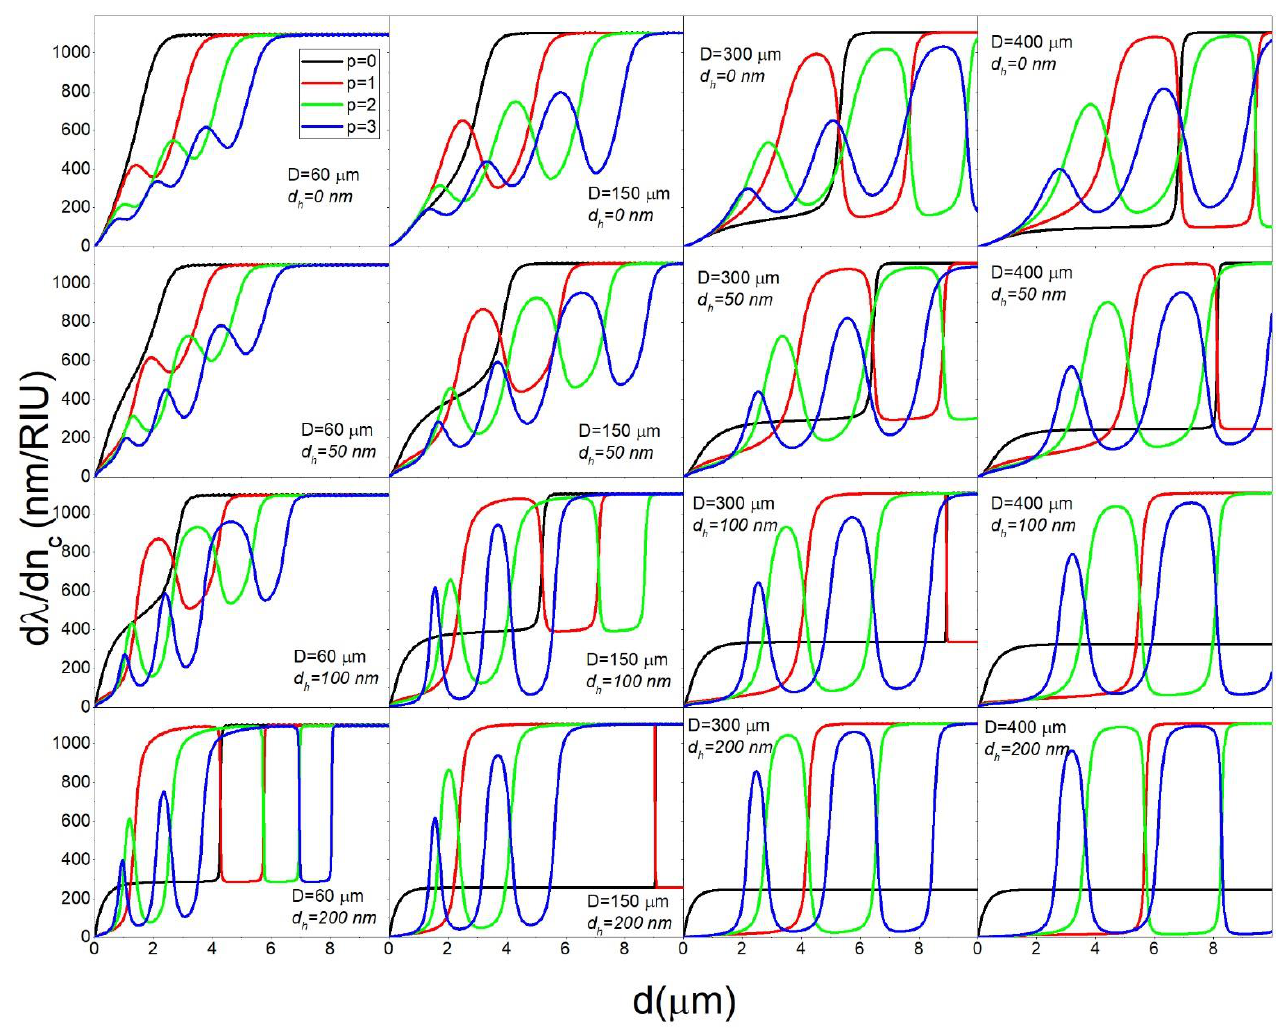
Figure 6. The dependence of ∂λ / ∂ n c on d for n c = 1.4 and n h = 1.9 calculated for select values of p , d h and D . Table 1. Calculated ∂λ / ∂ n c for n c = 1.4, n h = 1.9, D = 150 µ m at d corresponding to the first local maximum for a given p for d h = 0 and for the optimum d h that maximizes ∂λ / ∂ n c at d . p